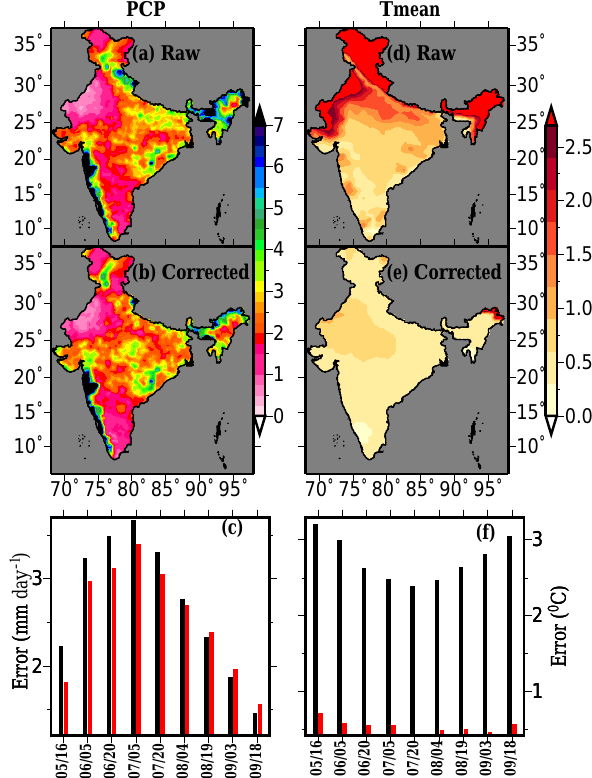
Figure 3. Median absolute error (MAE) in forecast at the 45-day accumulation period from the IITM ensemble before and after bias correction. (a, b) Median (of all forecast dates) MAE (mmday − 1 ) in precipitation forecast before and after bias correction. (c) Com- parison of the all-India median MAE for each forecast date. (d–f) Same as (a–c) but for daily mean temperature in ◦